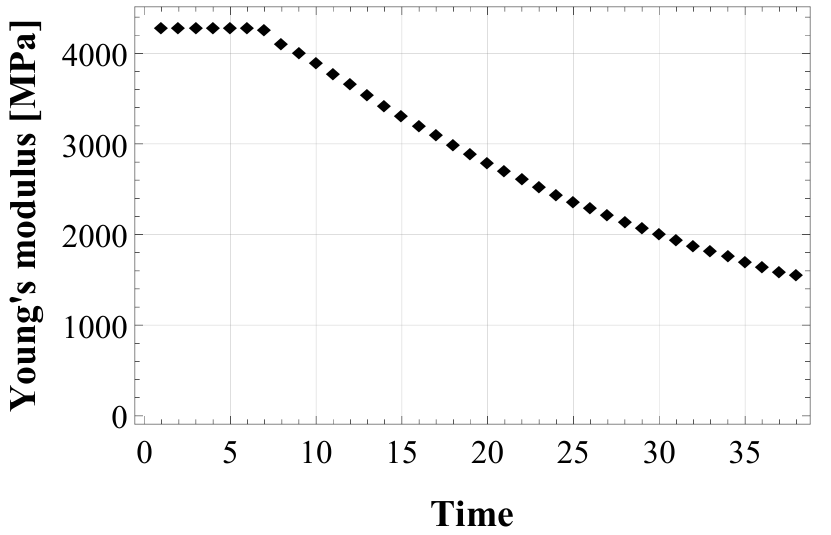
Figure 2. Evolution of the experimental Young’s modulus of the epoxy-based adhesive XA7416, calculated from tensile test data by